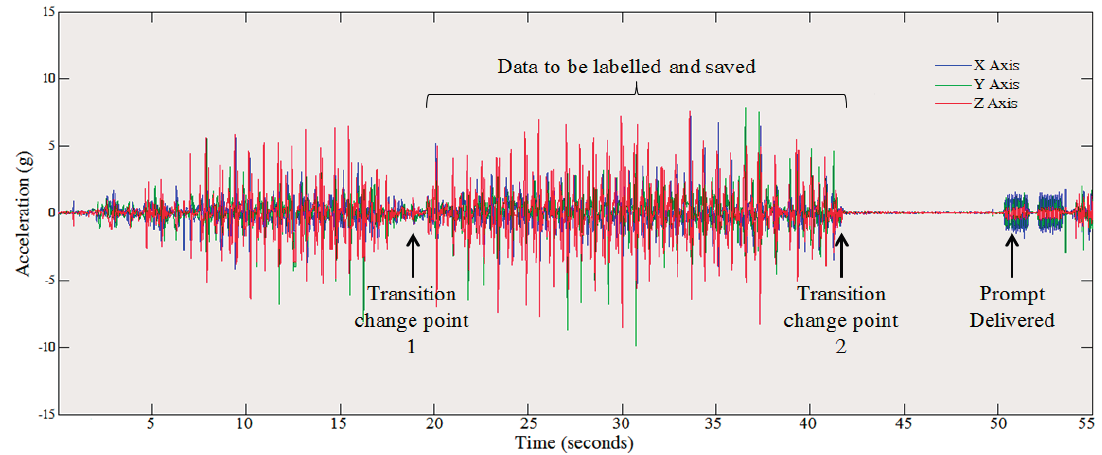
Figure 7. Plot of accelerometry data obtained during experimentation. Two high frequency vibrations can be clearly viewed in the accelerometer trace. This relates to the vibration alert initiated as part of the prompt